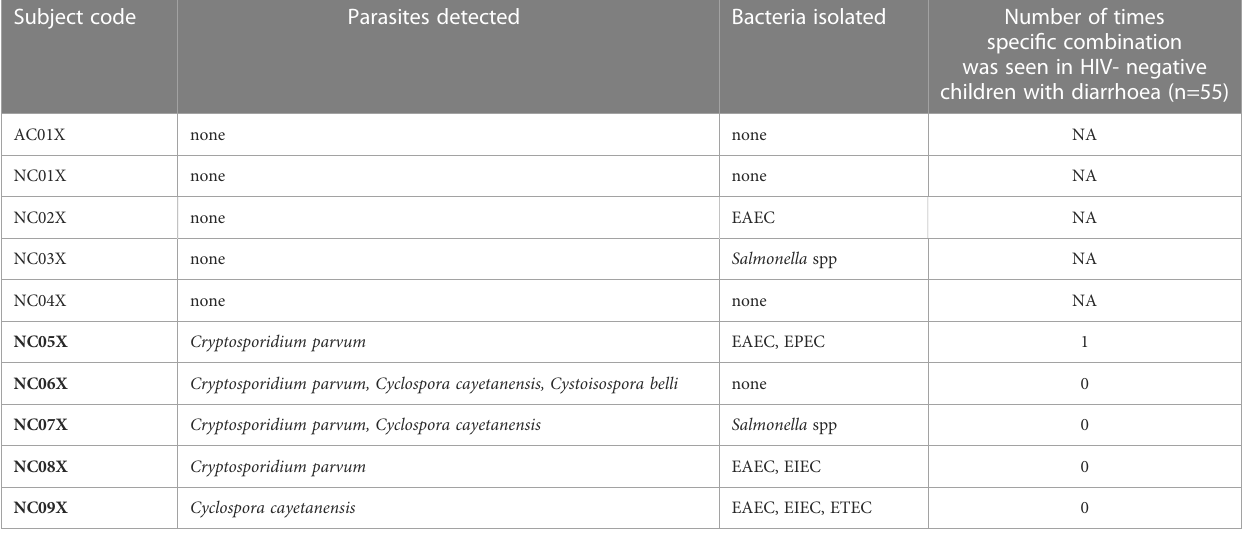
TABLE 3 Pathogens identi fi ed in diarrhoeal stool specimens from the ten children with